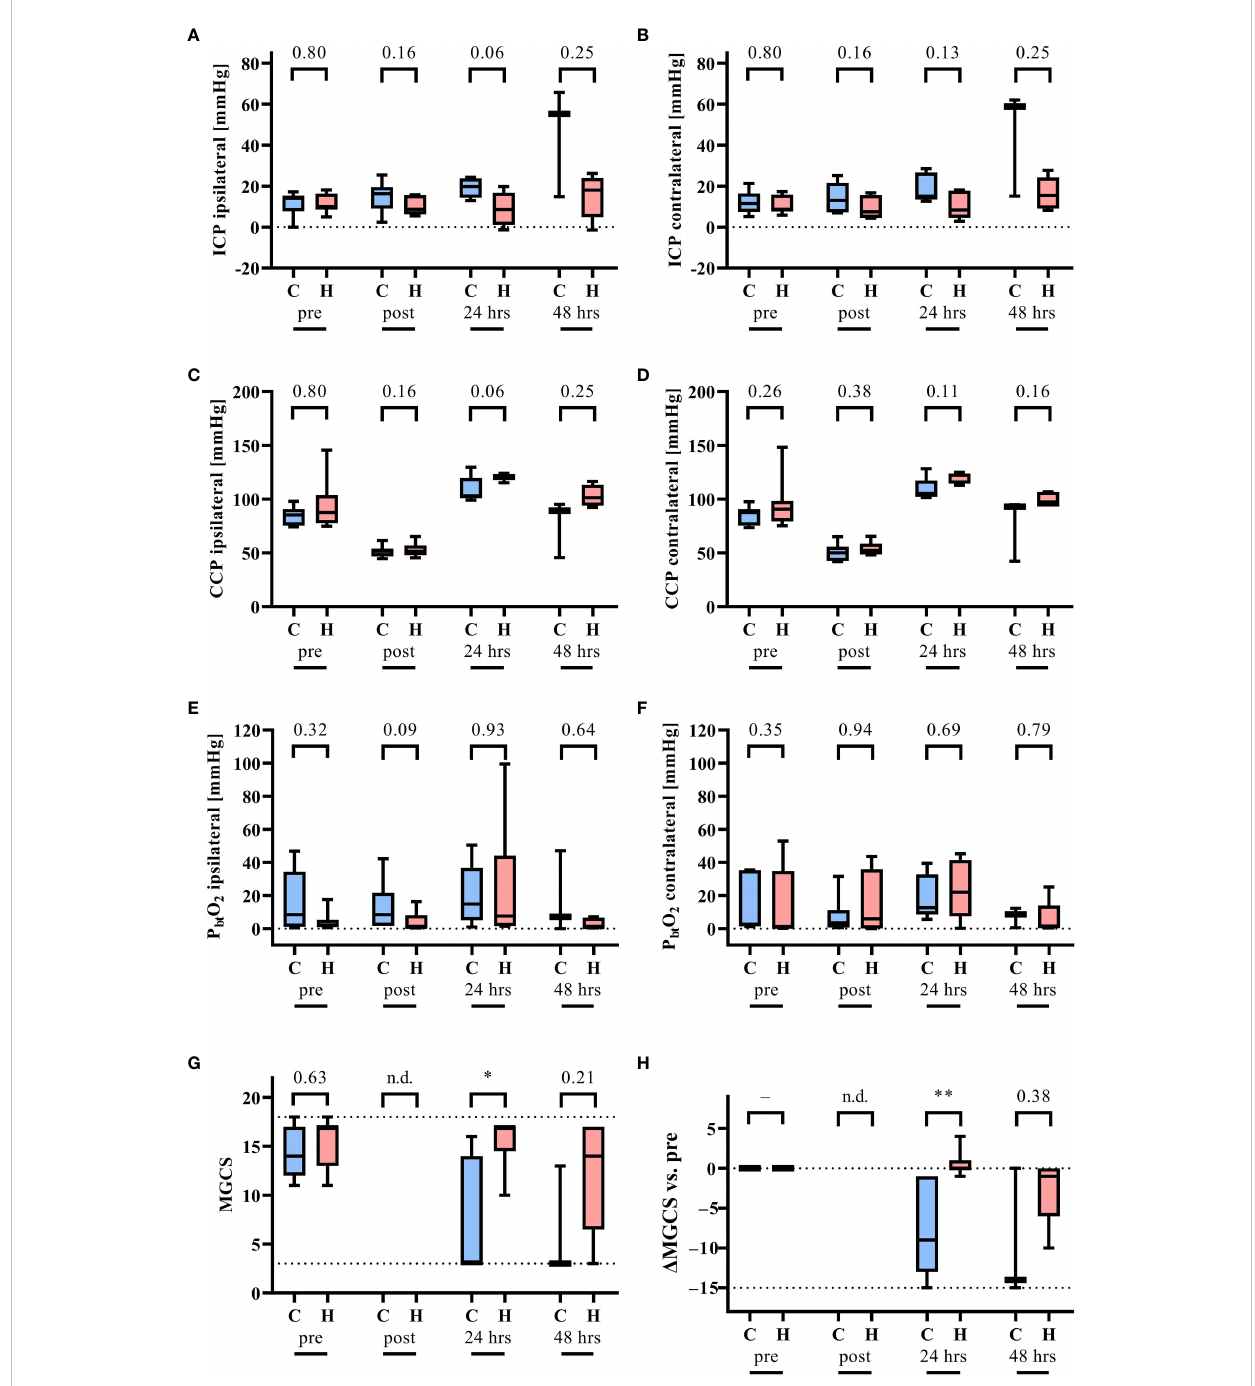
FIGURE 4 Monitoring of intracranial pressure (ICP), the cerebral perfusion pressure (CCP) and the partial pressure of O 2 in brain tissue (P bt O 2 ) at the site of ASDH (ipsilateral) and the opposing hemisphere (contralateral). Measurements were recorded before (pre) and after 2 hrs of hemorrhagic shock and acute subdural hematoma (post) as well as 24 hrs and 48 hrs after resuscitation n = 7/7 before shock, 7/7 after shock, 5/6 at 24 hrs, and 3/5 at 48 hrs per group for normoxemia (blue, control group, C) and targeted hyperoxemia (red, H), respectively. (A) ICP ipsilateral, (B) ICP contralateral, (C) CCP ipsilateral, (D) CCP contralateral, (E) P bt O 2 ipsilateral, (F) P bt O 2 contralateral, (G) modi fi ed Glasgow Coma Scale (MGCS), and (H) the difference of the MGCS in comparison to before shock. The dotted lines indicate the minimal and maximal possible values as for MGCS. Mann-Whitney U test. * = p < 0.05, ** = p < 0.01. n.d. = not determined. The box plots report the median, interquartile range, minimum, and